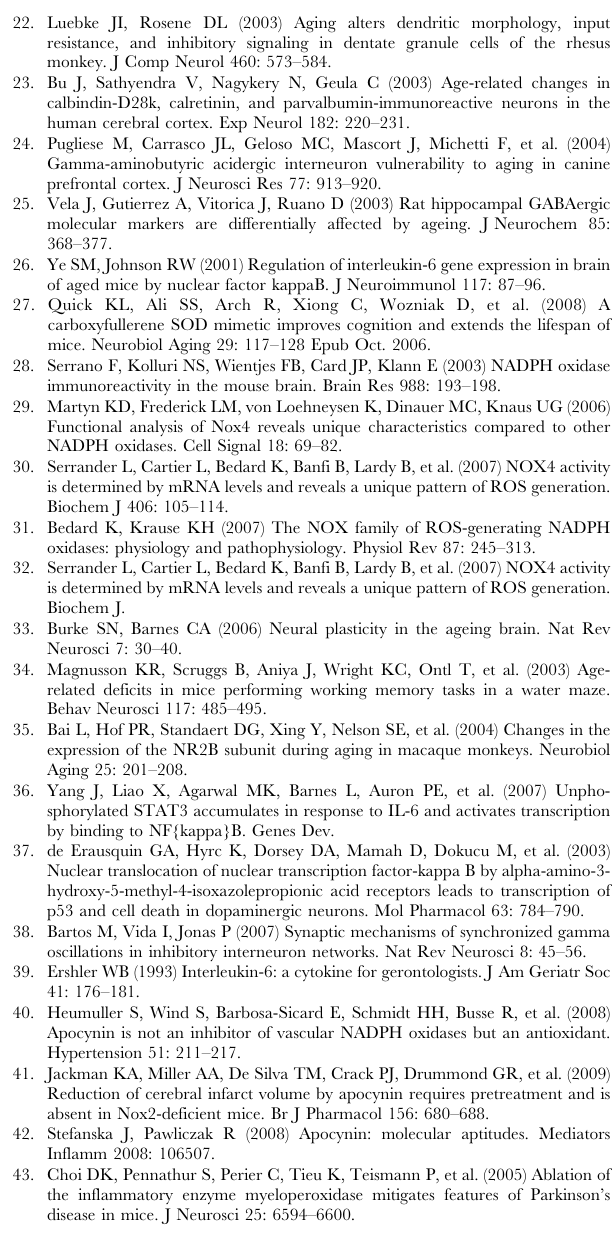
Figure S3 PV-interneurons in PFC. A statistically significant decrease in PV-positive cell counts was observed in the prelimbic